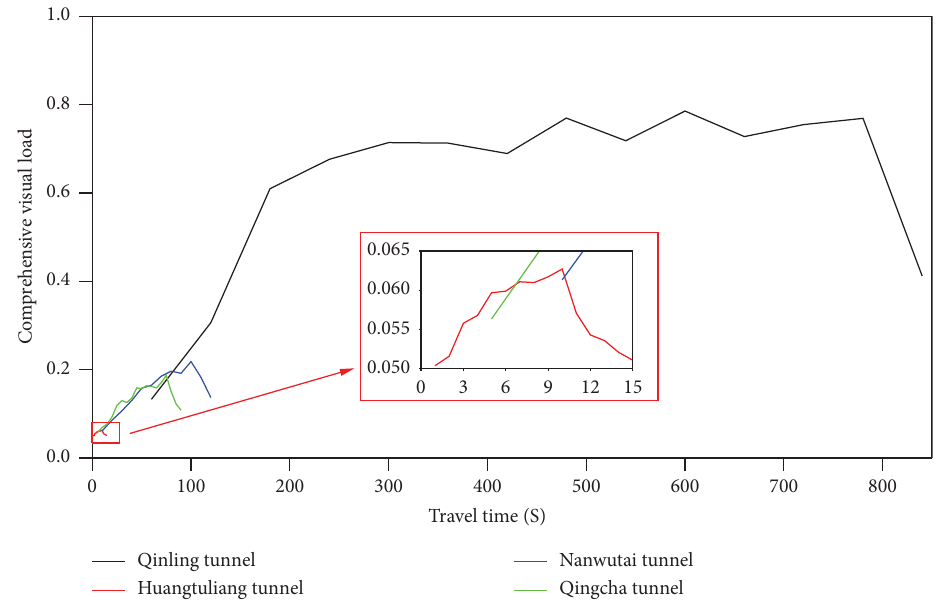
Figure 13: Changes in drivers’ comprehensive visual loads in each